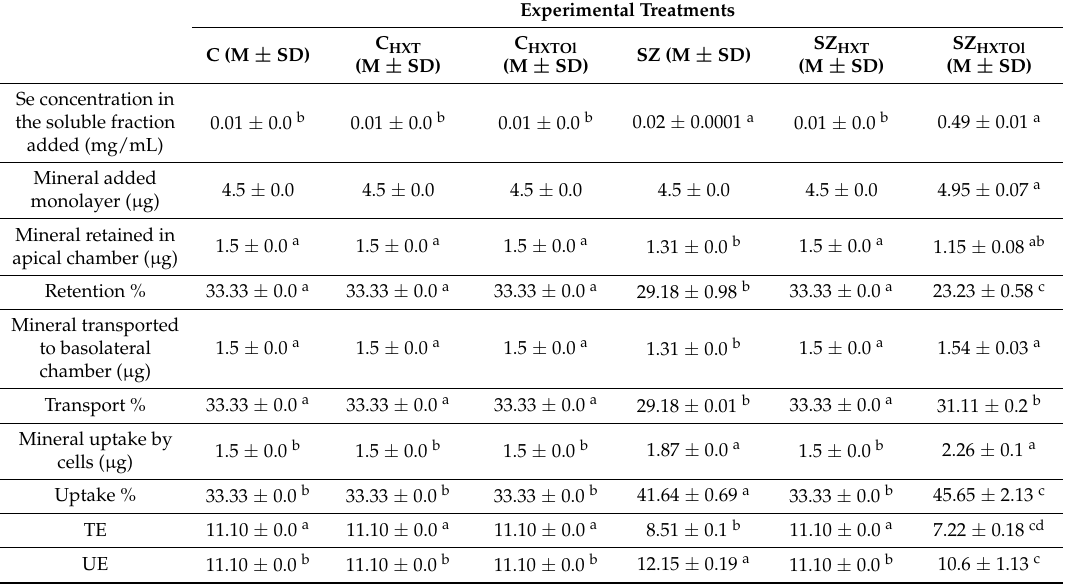
Table 7. Se retention, transport, and cellular uptake in enriched